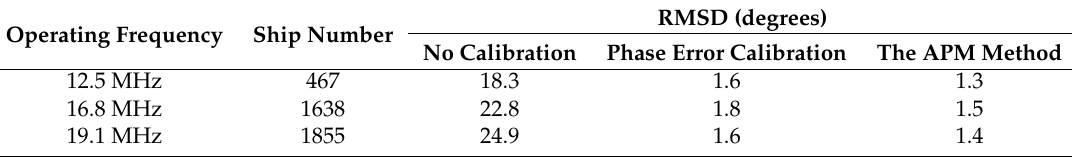
Table 2. Ship DOA estimation with the Zhujiajian MHF radar using three calibration strategies.